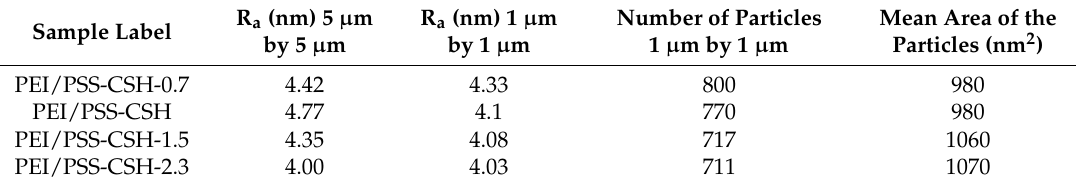
Figure 9. AFM images of ( a ) PEI/PSS-CSH-0.7; ( b ) PEI/PSS-CSH; ( c ) PEI/PSS-CSH-1.5 and ( d ) PEI/PSS-CSH-2.3 made of three bilayers. Table 5. Roughness value, number of particles, and mean area of the CSH particles in the PEI/PSS samples with different calcium to silicate (C/S) ratios made of three